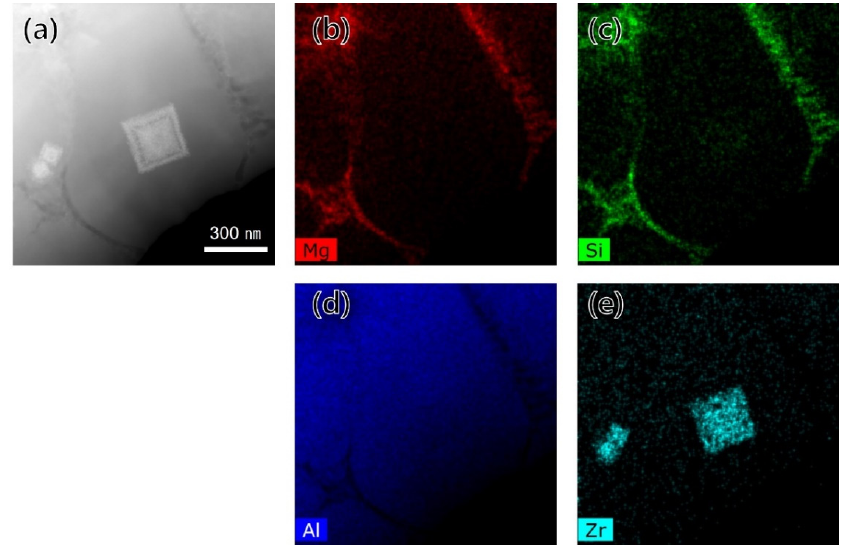
Figure 6. TEM-EDS mapping of a precipitate in the fine-grain region: ( a ) BF-TEM image, ( b ) Mg, ( c ) Si, ( d ) Al, and ( e ) Zr